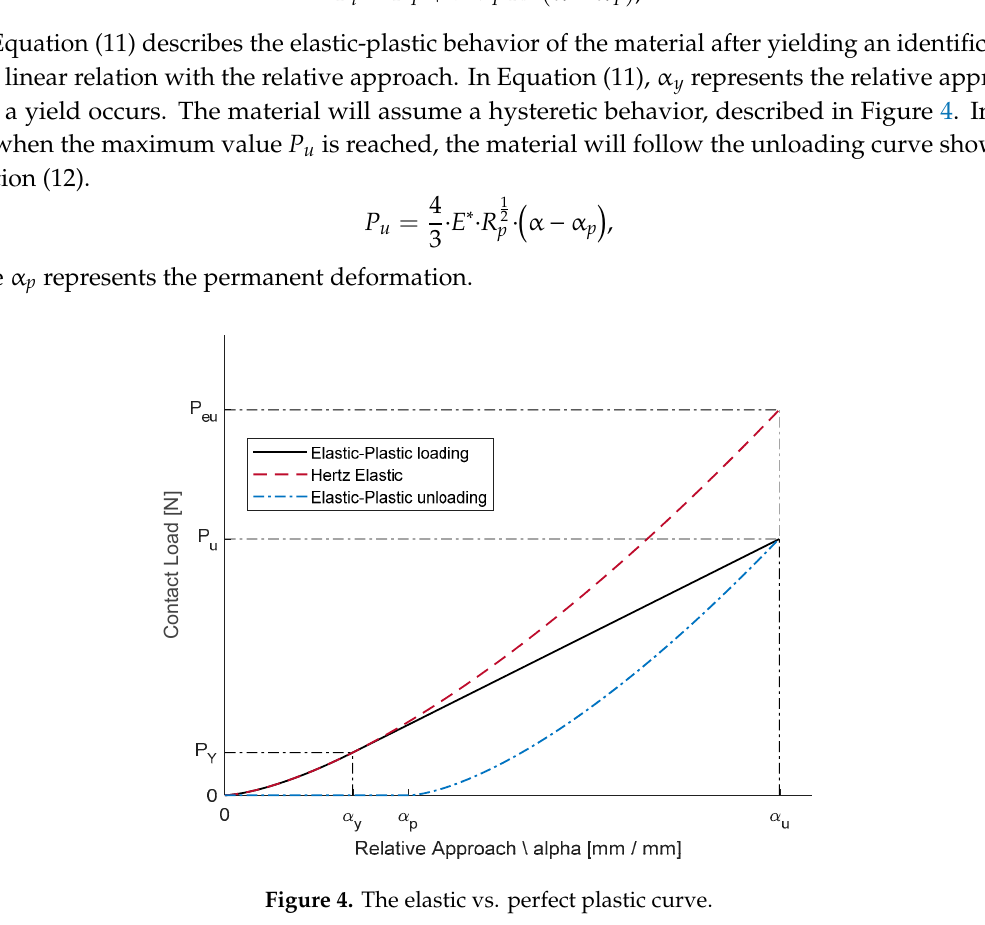
Figure 4. The elastic vs. perfect plastic curve.